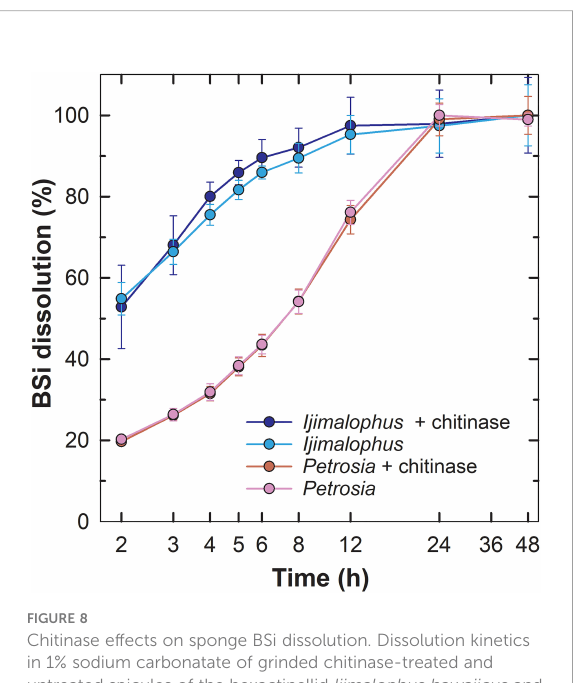
FIGURE 8 Chitinase effects on sponge BSi dissolution. Dissolution kinetics in 1% sodium carbonatate of grinded chitinase-treated and untreated spicules of the hexactinellid Ijimalophus hawaiicus and the demosponge Petrosia fi ciformis . Time (h) is presented in logarithmic